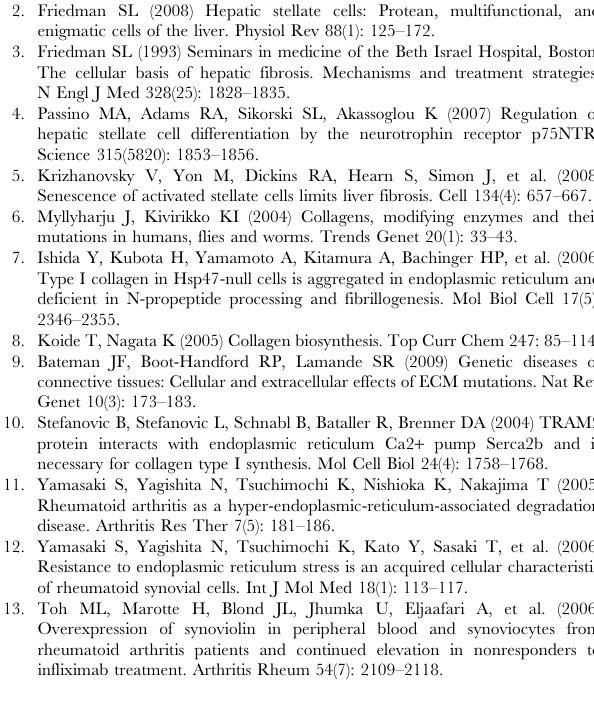
Figure S3 Serum biochemical tests for wt and Syno + / 2 mice in the CCl4-induced chronic hepatic injury model. The serum levels of aspartate aminotransferase (AST), alanine aminotransferase (ALT), lactate dehydrogenase (LDH), total bilirubin (T-bil), total protein, albumin (Alb), and the serum albumin/globulin (A/G) ratio for wt (n= 14) and Syno + / 2 mice (n =12) of the CCl4- induced chronic hepatic injury model. Data are represented as mean 6 SEM. Figure S4 Double immunofluorescence staining was performed in wt and Syno 2 / 2 MEFs using antibodies against synoviolin and PDI. Fluorescent images were visualized using a Zeiss LSM 510 META confocal fluorescence microscope (Carl Zeiss, Jena, Germany). The results were derived from 3 independent experiments. Scale bar = 20 m m.